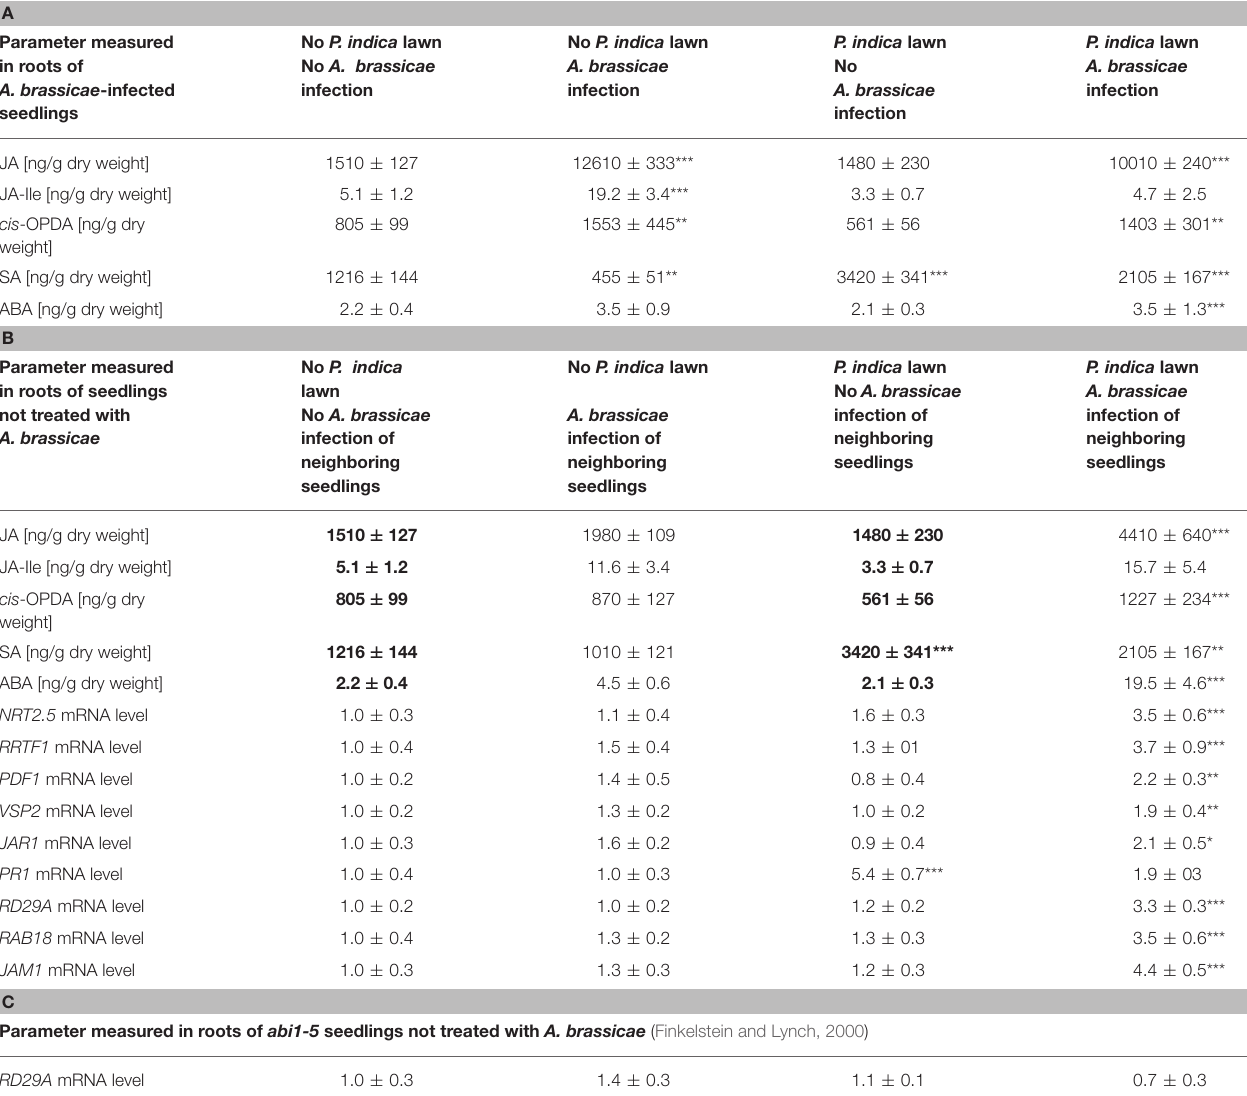
TABLE 1 | The experimental set-up is shown in Figures S1: 4 Arabidopsis seedlings were either transferred to plates without P. indica or to plates with a 1 week-old P. indica fungal lawn for 12